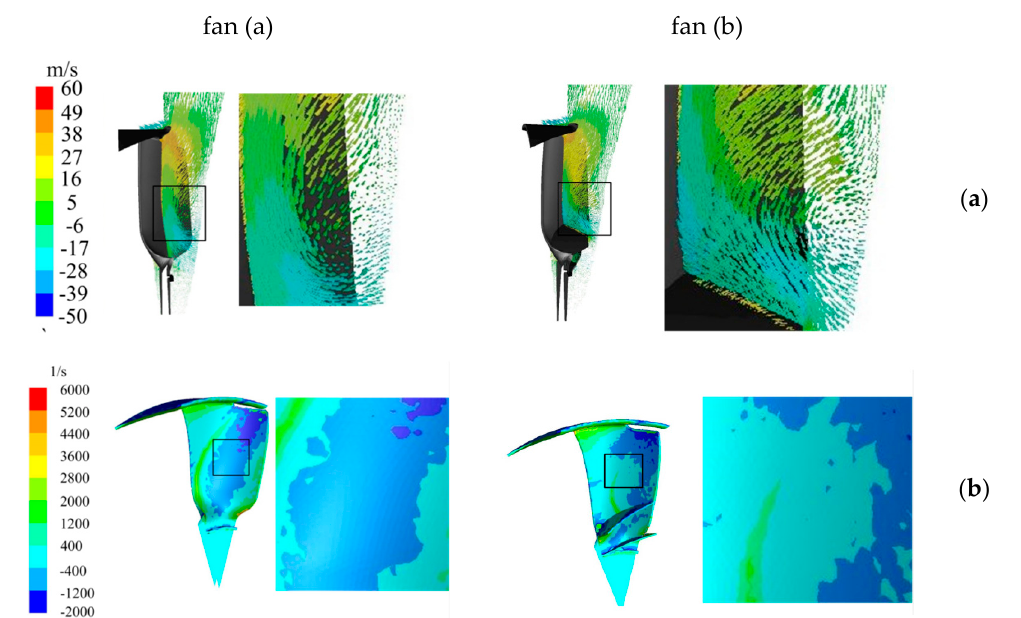
Figure 6. Flow-- fi eld characteristics of two fans. ( a ) Velocity contour pro fi les; ( b ) distribution of CV . Figure 6. Flow–field characteristics of two fans. ( a ) Velocity contour profiles; ( b ) distribution of CV.